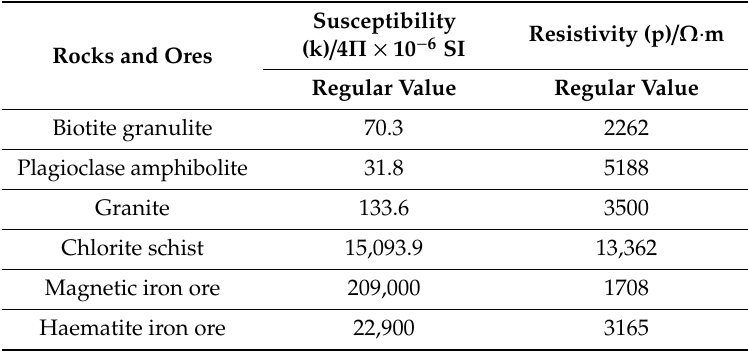
Table 1. Petrophysical properties in the Gongchangling iron ore concentration